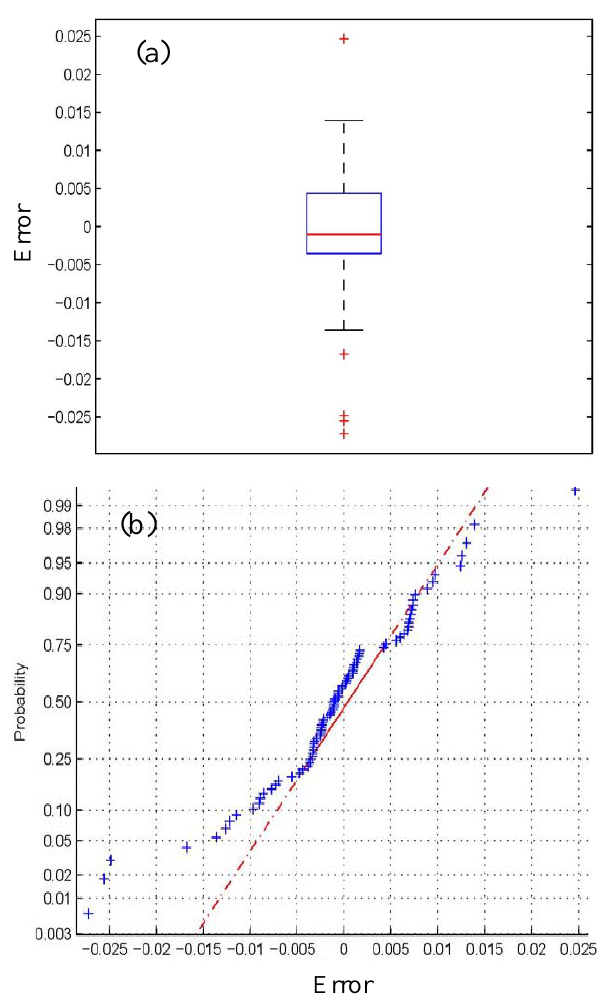
Fig. 6. Same as in Fig. 4 except for 2010